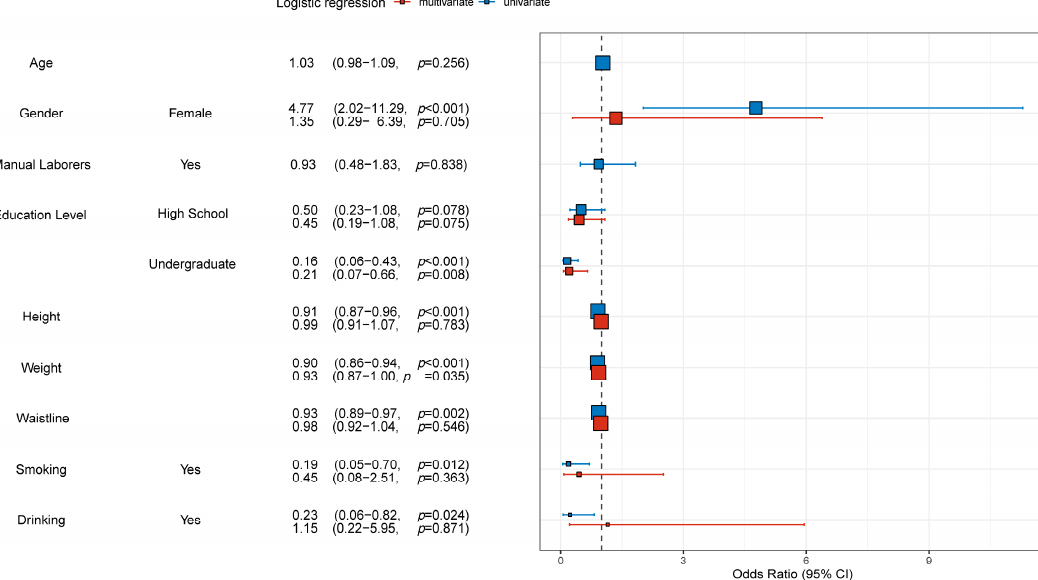
Figure 2. Univariate and multivariate logistic regression analyses for the validation group. Univariate and multivariate logistic regression analyses were performed for all factors. Odds ratios, confidence intervals, and p -values were shown. p < 0.05 meant that the difference was statistically significant. Abbreviations: OR, Odds ratios; CI, confidence intervals.